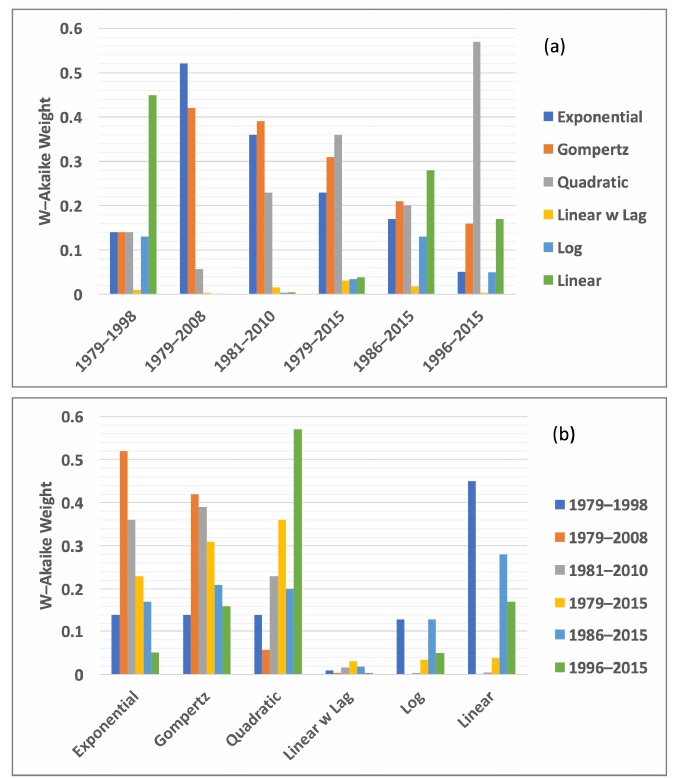
Figure 5. W–Akaike weights: ( a ) for each data period grouped by statistical models; and ( b ) for each statistical model grouped by data periods. Remote Sens. 2018 , 10 , x FOR PEER REVIEW